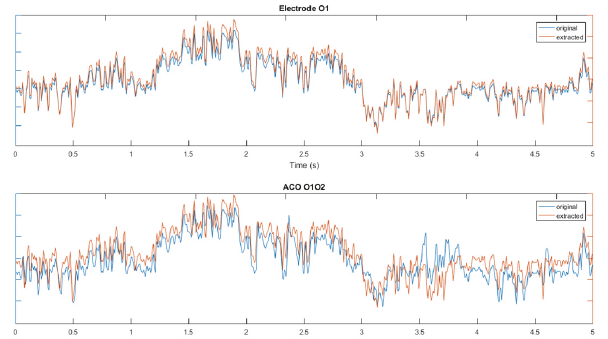
Figure 26: Comparison of the original signal and the reconstructed signal (extracted) implementing in the ACO model the mixture of signals O1 and ACO.